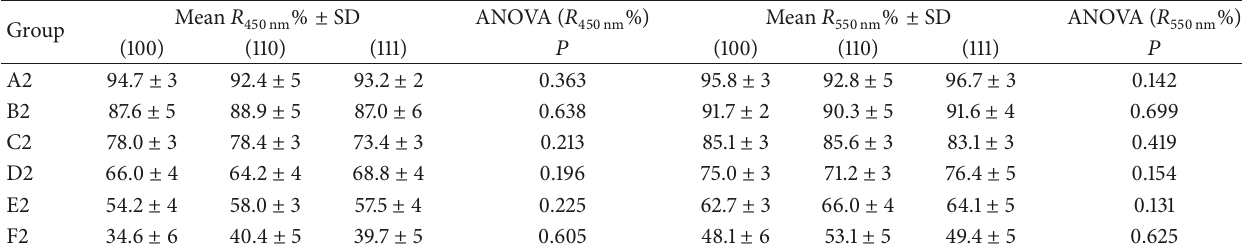
Table 3: Mean and one-way ANOVA of 𝑅 450 nm % and 𝑅 550 nm % among Groups A2–F2. Significance level 𝛼 = 0.05.